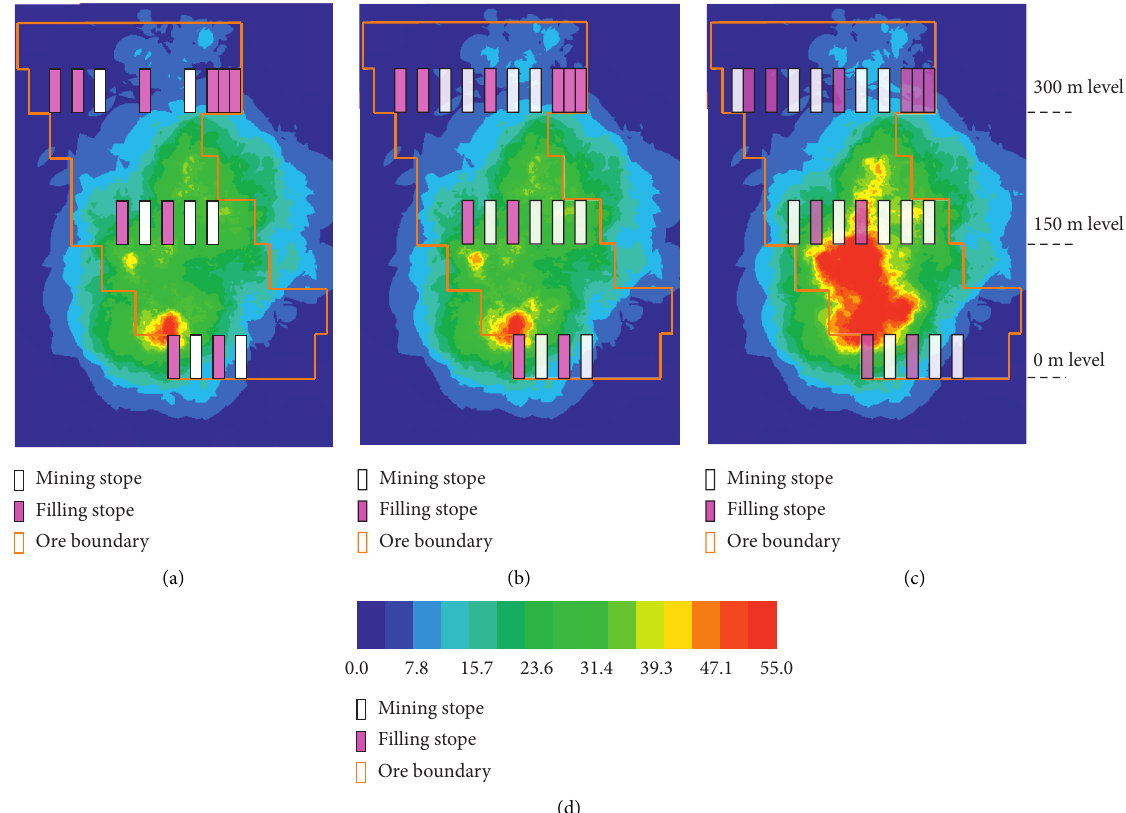
Figure 2: Cloud chart distributions of the microseismic event density. (a) 2017.6. (b) 2017.9. (c) 2017.12. (d) Legend (per square